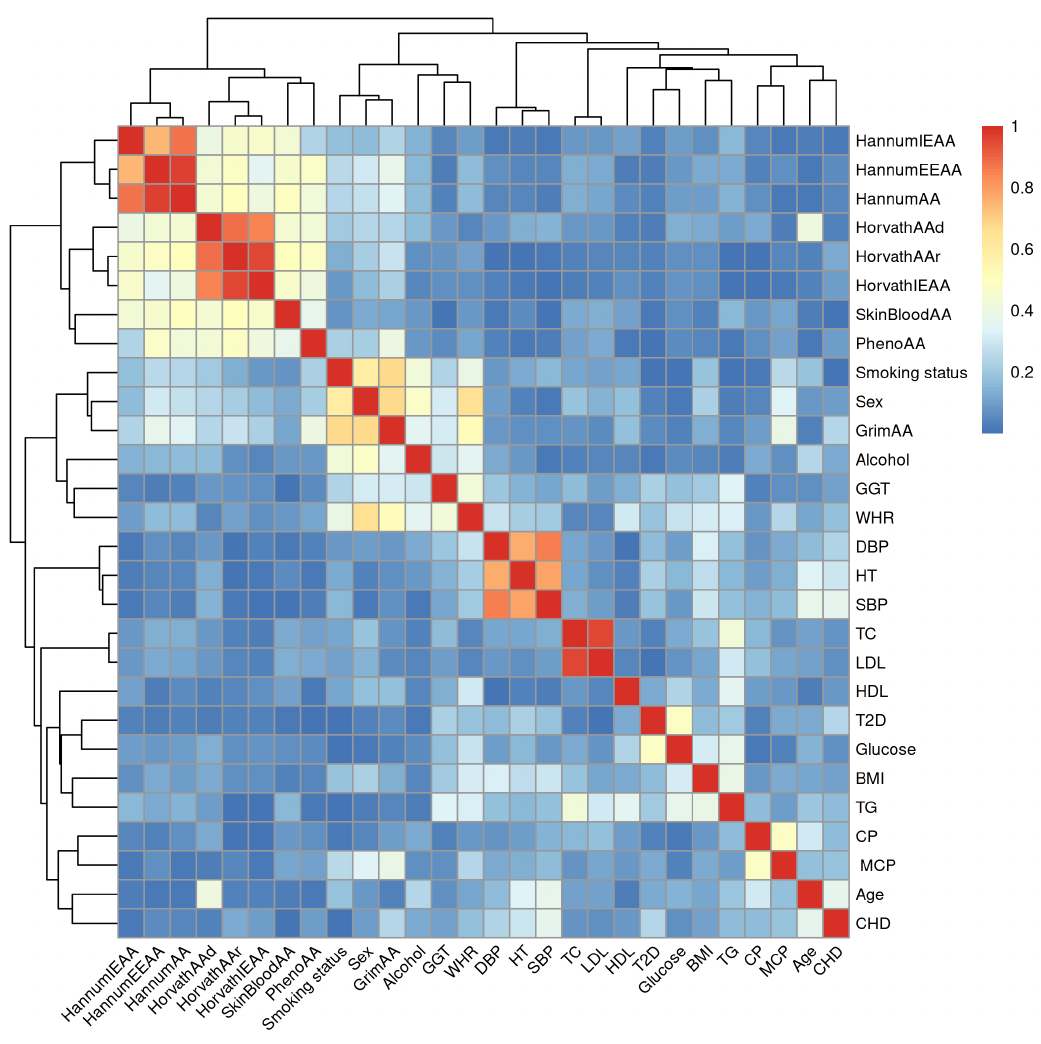
Figure 1. Heatmap of the correlations between all available traits and epigenetic age accelerations, based on Spearman correlation and unsupervised